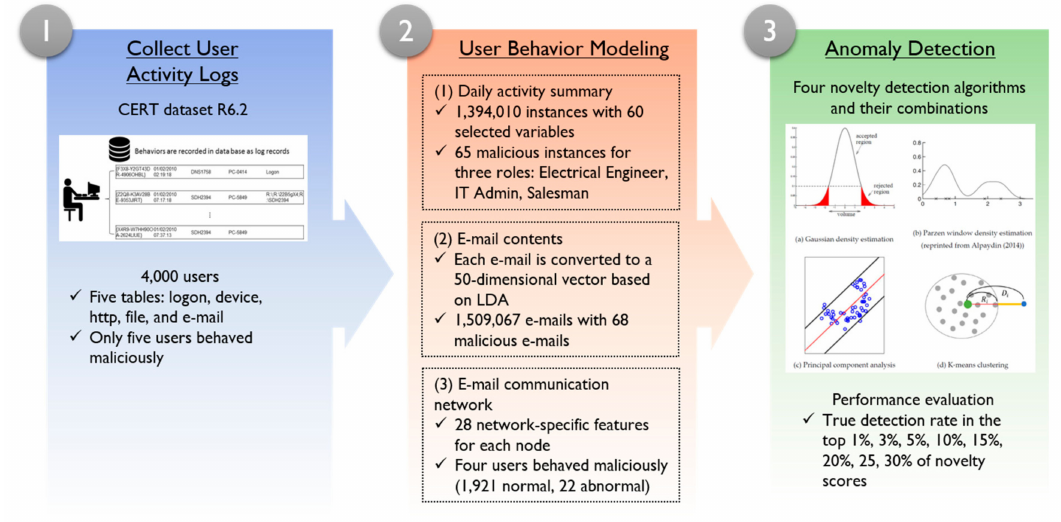
Figure 3. Insider-threat detection